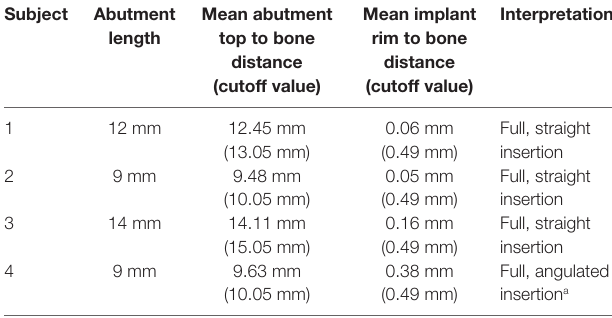
TABle 4 | Cone beam CT measurements.